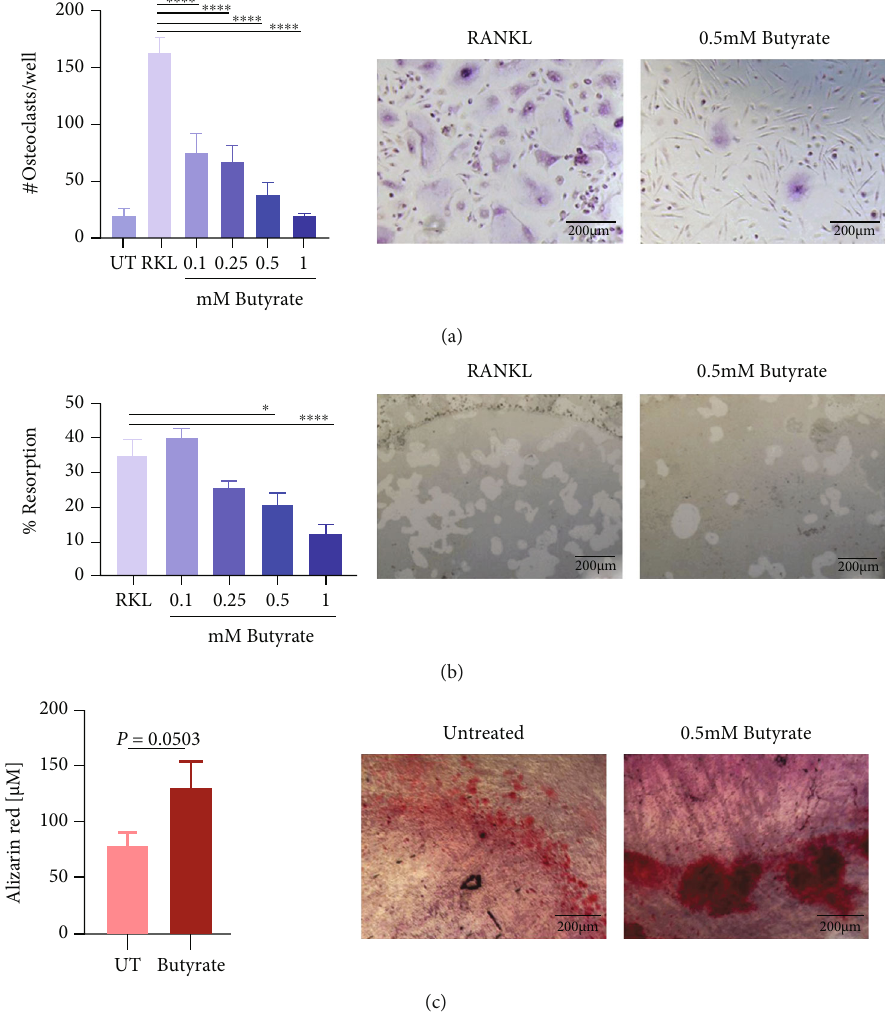
Figure 1: Butyrate inhibits human osteoclast formation and resorption. Impact of butyrate on cells involved in bone healing. (a) Osteoclast precursor cells were cultured with 20ng/mL M-CSF and 10 ng/mL RANKL and with 0.1mM, 0.25mM, 0.5mM, or 1mM butyrate, respectively. Osteoclast formation was quanti fi ed by means of TRAcP staining. Data shown are means ð n = 3independent donors, triplicatesper donor were used Þ ± SEM . Representative images showing TRAcP-stained osteoclasts in the absence (left image) and presence of 0.5mM butyrate (right image). (b) Mature osteoclasts were cultured on a hydroxyapatite-coated plate in the presence and absence of butyrate with concentrations as indicated above. Resorption areas were quanti fi ed by means of von Kossa staining. Data shown are means ± SEM ( n = 1 donor, performed in triplicate, and two pictures per well were taken and quanti fi ed). Representative images showing resorbed areas of hydroxyapatite-coated wells in the absence (left image) and presence of 0.5mM butyrate (right image). (c) MSCs were cultured in osteogenic media and calcium deposits were quanti fi ed by means of Alizarin red staining in the absence and presence of 0.5mM butyrate. Data shown are means ð n = 3 independentdonors Þ ± SEM . Representative images of Alizarin red staining in the absence (left image) and presence of 0.5mM butyrate (right image). Scale bar in all images = 200 μ m ; UT=untreated; RKL =RANKL; ∗∗∗∗ p < 0 : 0001 ; ∗ p < 0 : 05